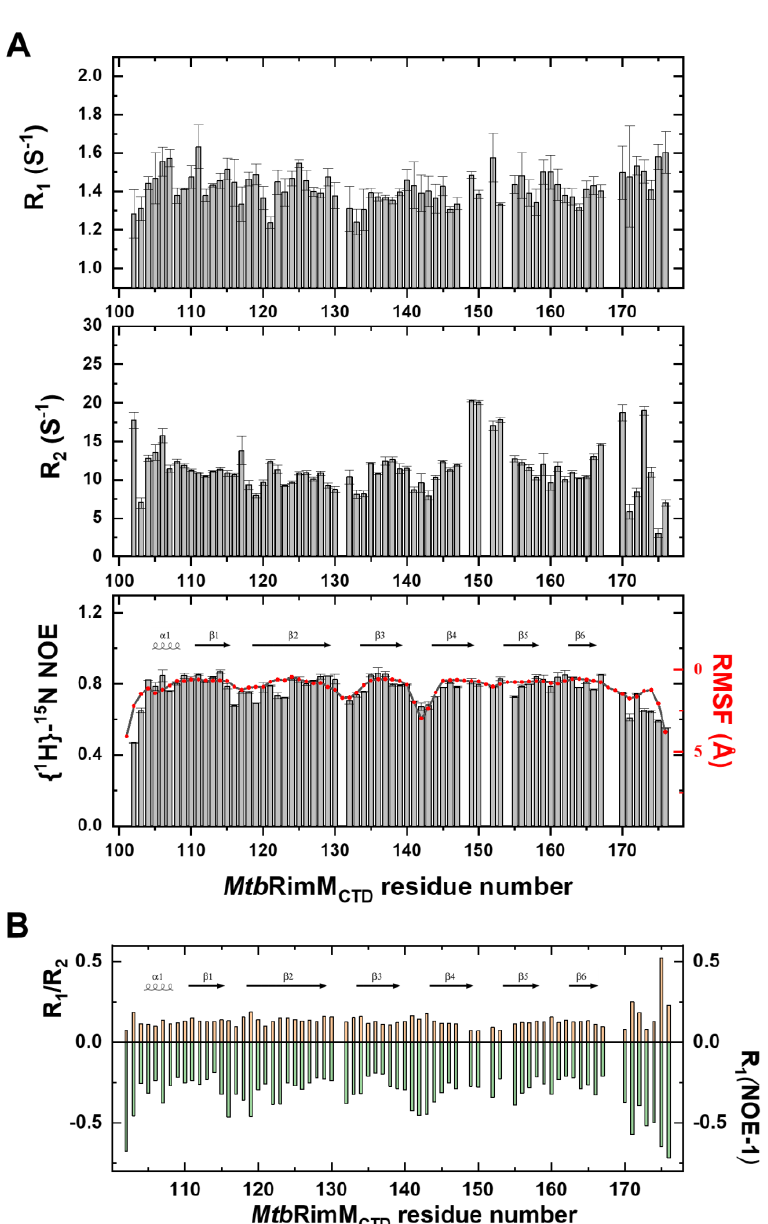
Figure 4. Nuclear magnetic resonance (NMR) relaxation measurements of backbone amide groups in Mtb RimM CTD . ( A ) Plots of backbone amide dynamics parameters R 1 (upper panel), R 2 (middle panel), and { 1 H}- 15 N heteronuclear steady-state nuclear Overhauser effect (hNOE, lower panel) versus residue number. Root-mean-squared fluctuation (RMSF) per residue calculated from molecular dynamics (MD) simulation is plotted over the hNOE graph, as both parameters reveal fast motion features in line with the secondary structure elements shown above the plot. ( B ) Plot of the R 1 /R 2 ratio and R 1 (NOE-1) value versus residue number. Cross-relaxation rate σ HN is characterized by R 1 (NOE-1) for clearly comparing with the R 1 /R 2 ratio. Secondary structure elements are shown above the column plot.